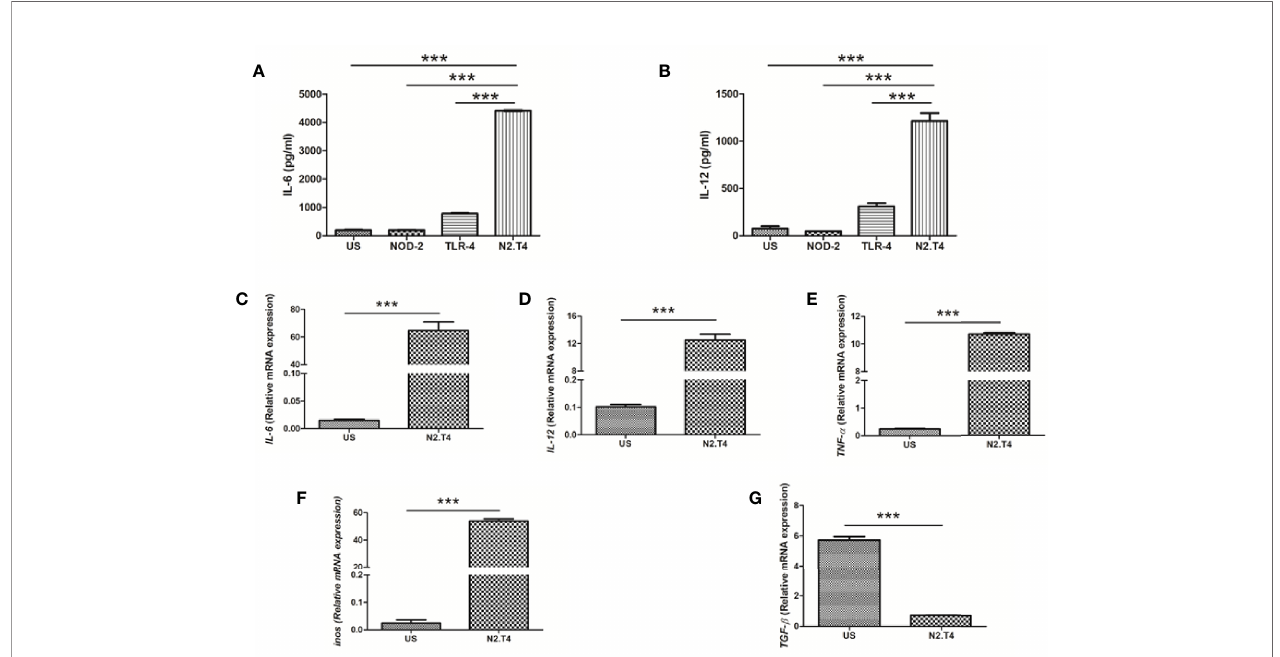
FIGURE 2 | Cumulative signaling through NOD-2 and TLR-4 stimulates MSC to release IL-6 and IL-12. (A, B) MSCs were cultured with the ligands of NOD-2 and TLR-2 (N2.T4). The controls were set using unstimulated MSCs (US) or stimulated with either the ligand of NOD-2 (NOD-2L) or TLR-4 (TLR-4L). The culture SNs were collected after 48h and estimated for the production of (A) IL-6 and (B) IL-12 cytokines by ELISA. (C – G) The MSCs were stimulated as indicated above (A, B) and the mRNA expression of Il6 (C) , Il12 (D) , Tnfa (E) , Inos (F) and Tgfb (G) was performed by RT-PCR. Graphs depict the ‘ mRNA expression relative to unstimulated (US) control ’ . Data expressed as mean ± SD are representative of two independent experiments. Statistical analysis was done using one way ANOVA for ELISA and unpaired t-test for RT-PCR. ***p <